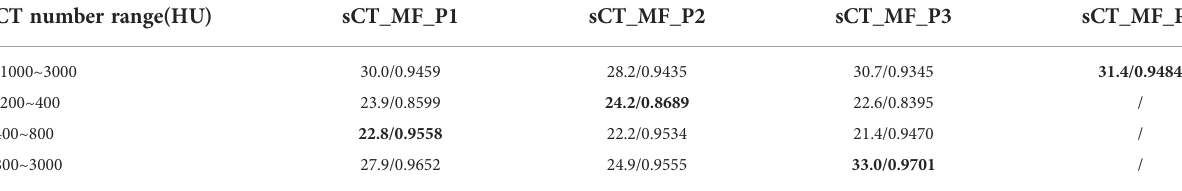
sCT_MF_P1, metal-freesCTimagesobtainedbytheprepossessing methodnamedP1; sCT_MF_P2,metal-free sCTimagesobtainedbytheprepossessingmethodnamedP2;sCT_MF_P3, metal-freesCTimagesobtainedbytheprepossessingmethodnamedP3;metal-freesCTimagesobtainedbythecombinedprepossessingmethodnamedP4.ThebestPSNRandSSIMvalues in different HU ranges of sCT_MF images are marked in